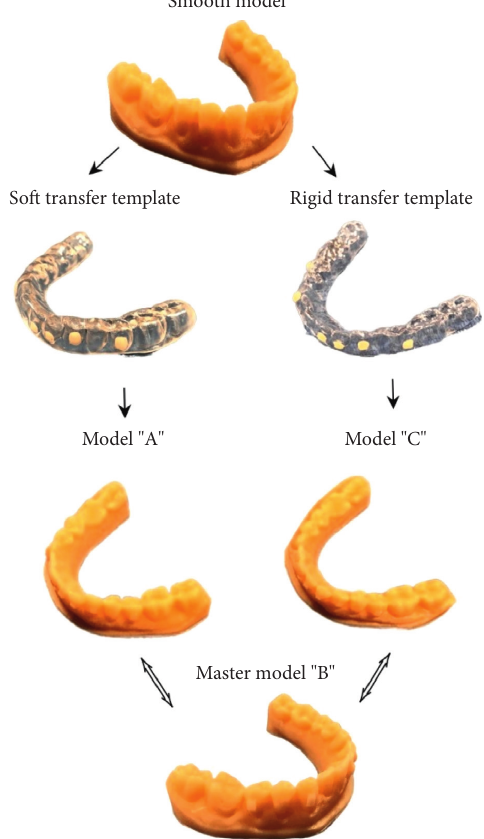
Figure 1: Illustration of the models to be compared. Table 1: Combination grid of the samples obtained by using the two resin-based composites and the two transfer templates. The table indicates the number of samples associated with each